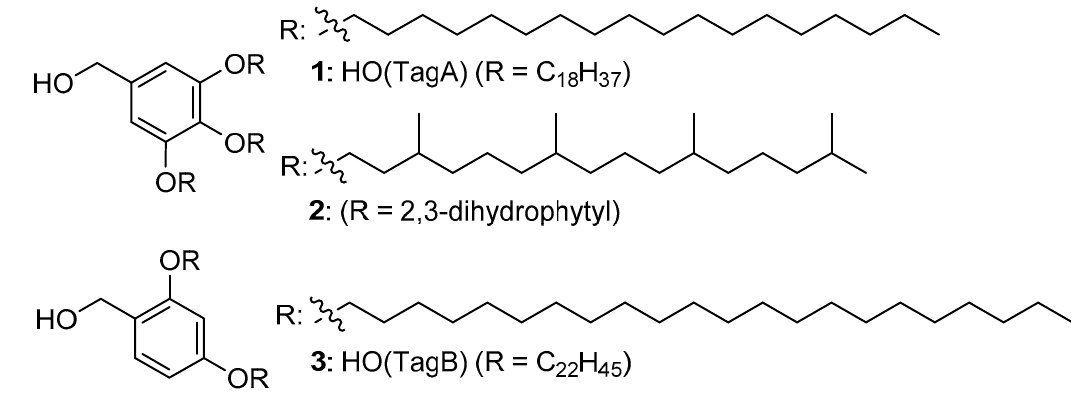
Figure 1. Reported chemical tags for peptides synthesis.